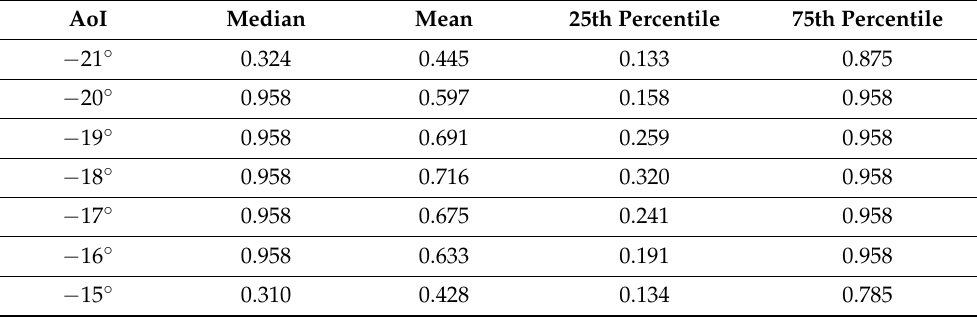
Table 4. Processed intensity data for red transparent plastic.